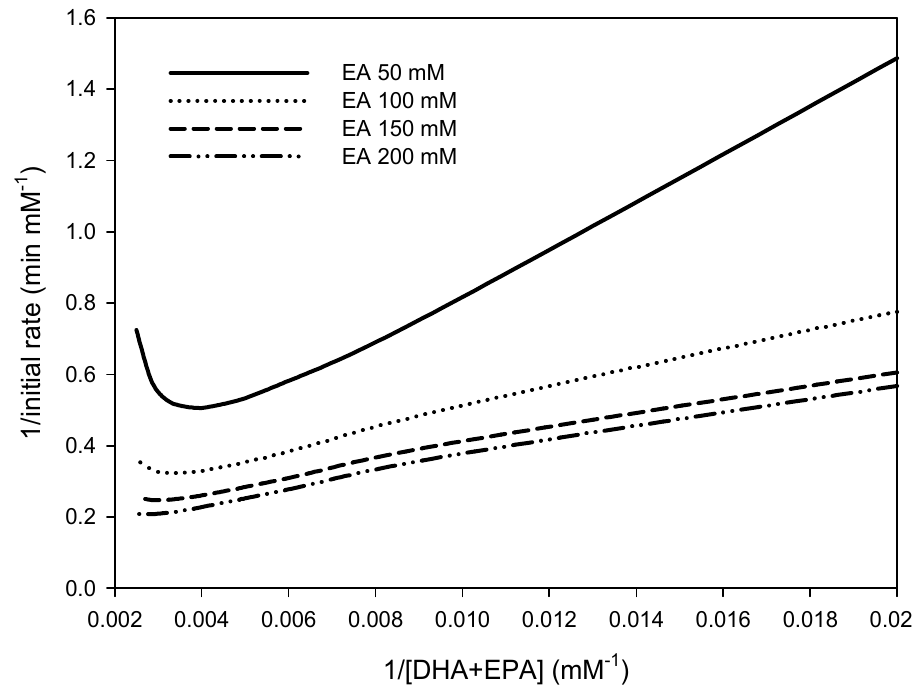
Figure 2. Lineweaver–Burk plot of reciprocal initial reaction rate vs. reciprocal concentrations of DHA+EPA concentrate at various EA concentrations during the synthesis of DHA+EPA ethyl ester via lipase-catalyzed acidolysis.